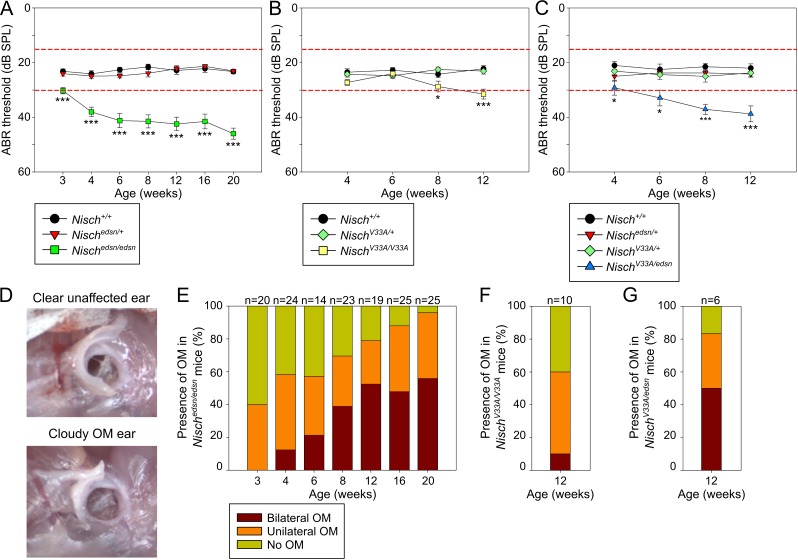
Mild to moderate hearing impairments in Nischedsn/edsn, NischV33A/V33A and Nischedsn/V33A mice due to otitis media.(A-C) Click-evoked ABR thresholds across a time course show a mild to moderate progressive hearing impairment in (A) Nischedsn/edsn, (B) NischV33A/V33A and (C) NischV33A/edsn mice. Expected ABR threshold range for normal hearing was between 15–30 dB SPL (dashed red lines). * P < 0.05; *** P < 0.001. (A) Nisch+/+, n = 10–33; Nischedsn/+, n = 12–33; Nischedsn/edsn, n = 14–25. (B) Nisch+/+, n = 10; NischV33A/+, n = 13; NischV33A/V33A, n = 10. (C) Nisch+/+, n = 5; Nischedsn/+, n = 6; NischV33A/+, n = 4; NischV33A/edsn, n = 6. Error bars indicate standard error of mean. A Kruskall-Wallis test was performed followed by Dunn’s multiple comparison tests for post-hoc analysis. (D) Visual inspection of the tympanic membrane is a simple method for diagnosing OM. Wild-type (Nisch+/+) mice have no visible fluid behind the tympanic membrane and the malleus is easily recognizable, while affected Nischedsn/edsn mice have fluid behind the tympanic membrane and the malleus is obscured. (E) The incidence of bilateral and unilateral OM increases in prevalence with age in Nischedsn/edsn mice. (F, G) At 12 wk, an increased proportion of (F) NischV33A/V33A and (G) NischV33A/edsn mice display bilateral and unilateral OM.